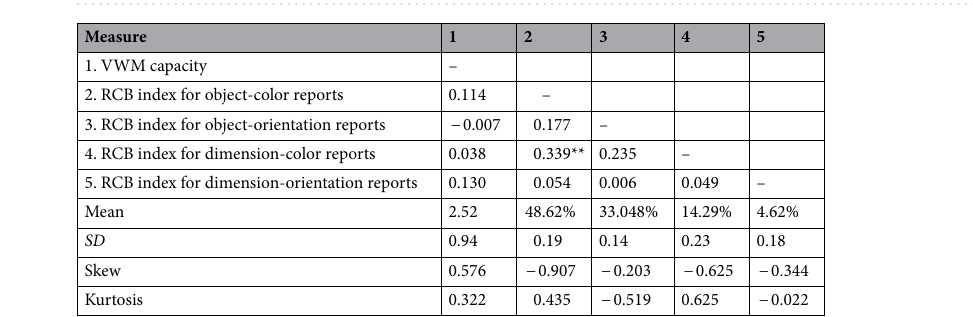
Figure 4. Offsets results for the neutral cue and valid cue conditions for each task, separated into ( a ) color report trials and ( b ) orientation report trials. “Object-based neutral cue” refers to the neutral cue condition in the object-based cue task. “Object-based valid cue” refers to the valid cue condition in the object-based cue task. “Dimension-based neutral cue” refers to the neutral cue condition in the dimension-based cue task. “Dimension-based valid cue” refers to the valid cue condition in the dimension-based cue task. Mean values with error bars show the standard errors of the means.